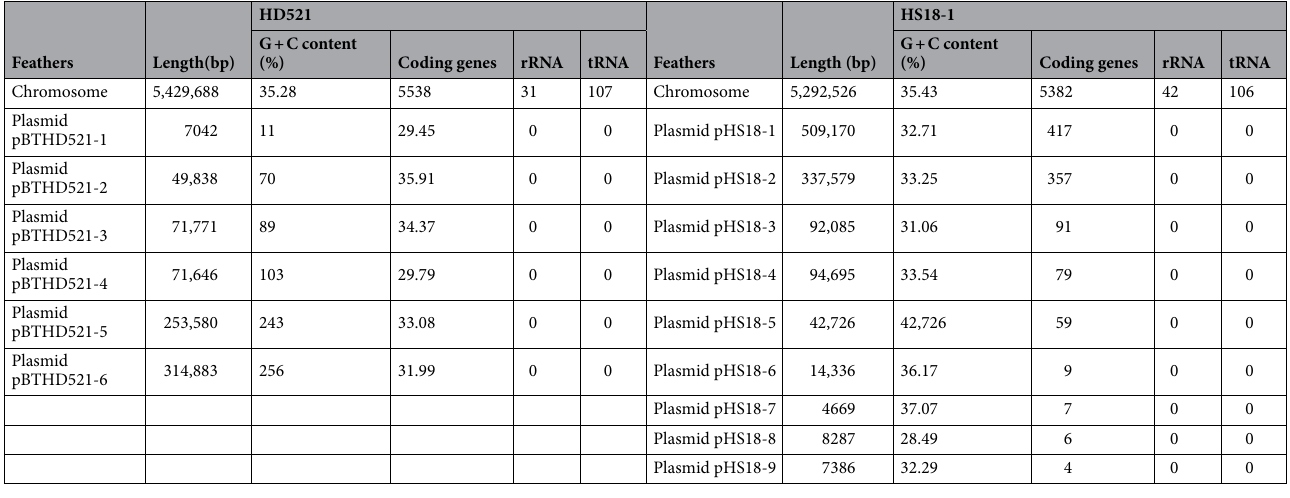
Table 1. Genomic composition of Bacillus thuringiensis strain HD521 and